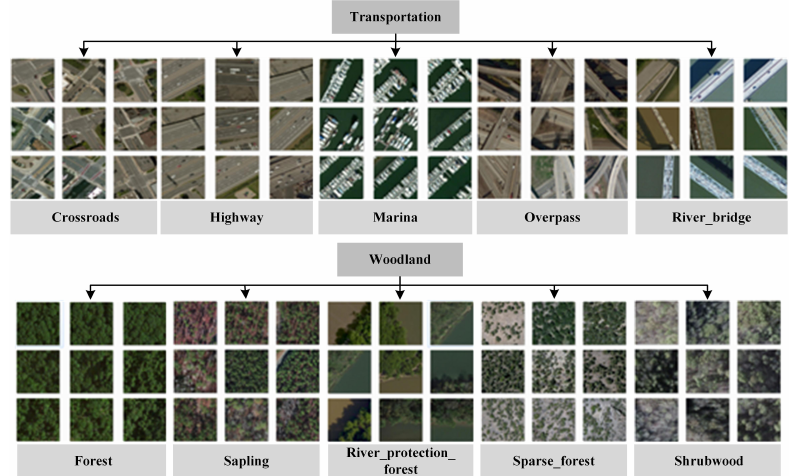
Figure 6. Root and leaf nodes of remote sensing image classification benchmark (RSI-CB). The category of transport corresponds to the sub-classes of crossroads, highway, marinas, overpass, river_bridge, and others. The next figure shows the category of woodland, with sub-classes corresponding to forest, sapling, river_protection_forest, sparse_forest, shrub wood, and